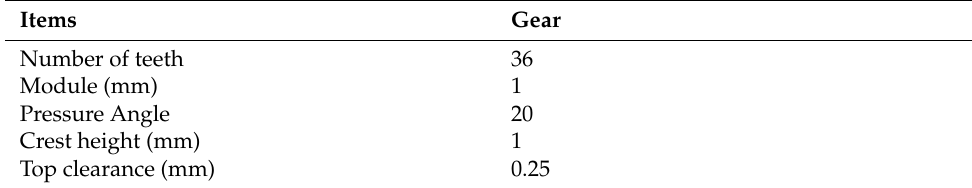
Table 2. Gear main parameters and geometric